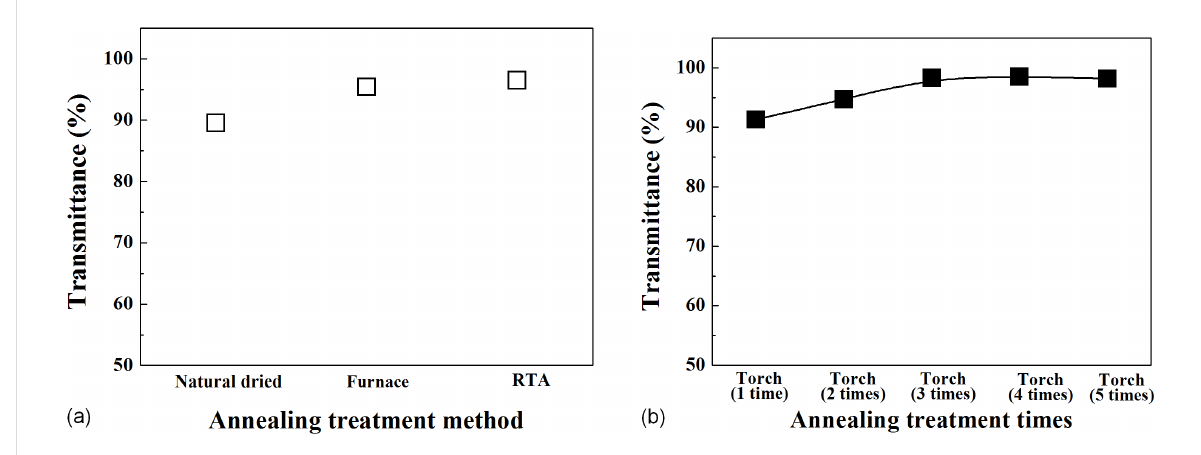
Figure 1: Transmittance (a) according to the annealing treatment method and (b) according to the number of annealing treatment using a gas torch.